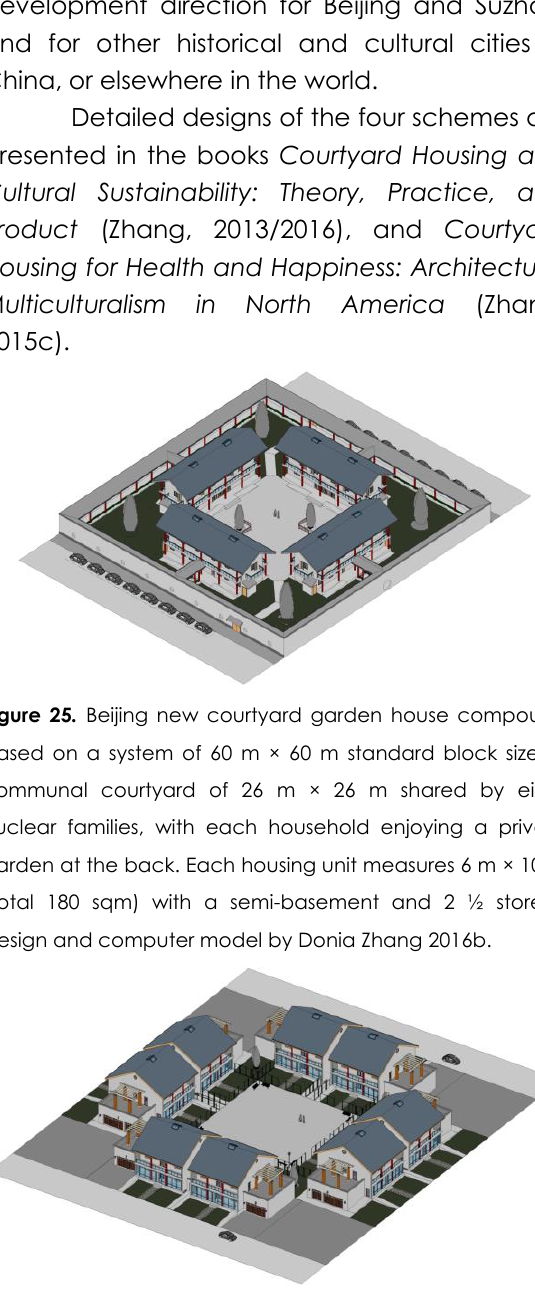
Figure 26. Beijing new courtyard garden house compound based on a system of 78 m × 78 m standard block size, the communal courtyard is 26 m × 26 m shared by eight nuclear families, with each household enjoying a private garden